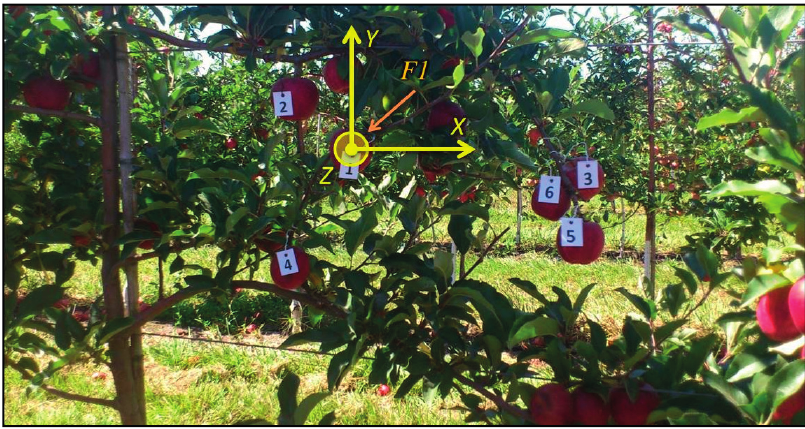
Figure 15. Ground truth data acquisition for a scene of the apple orchard.